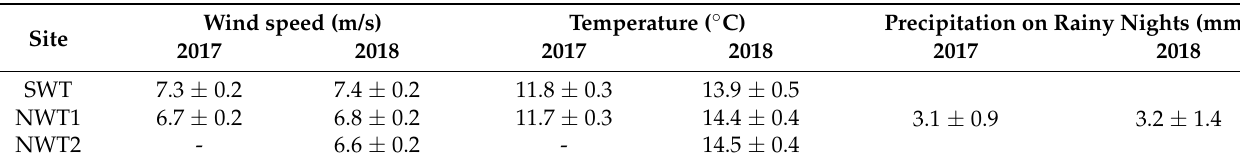
Table 2. The mean value and SE of the average wind speed per night and average temperature per night calculated for the whole survey period. Mean value and SE of the nightly precipitation on rainy nights (45 nights).